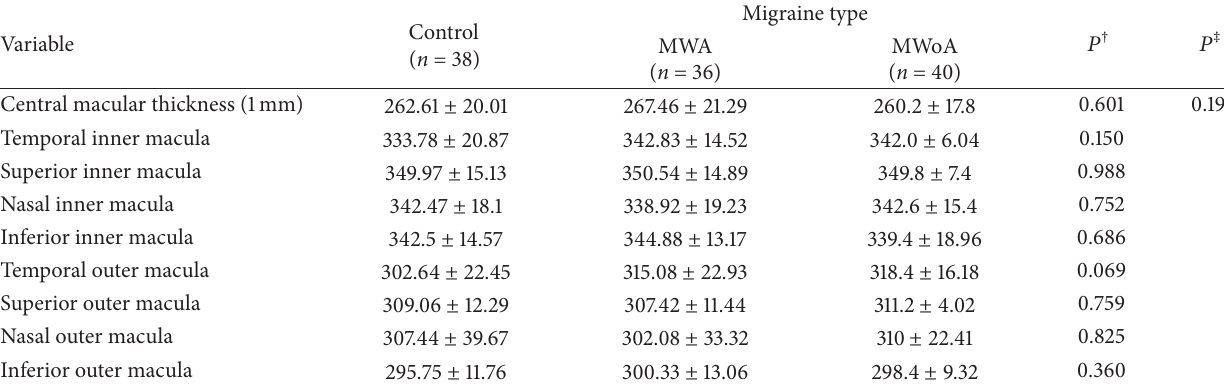
Table 4: Comparison of the mean macular thickness ( 𝜇 m) of the migraine types and control